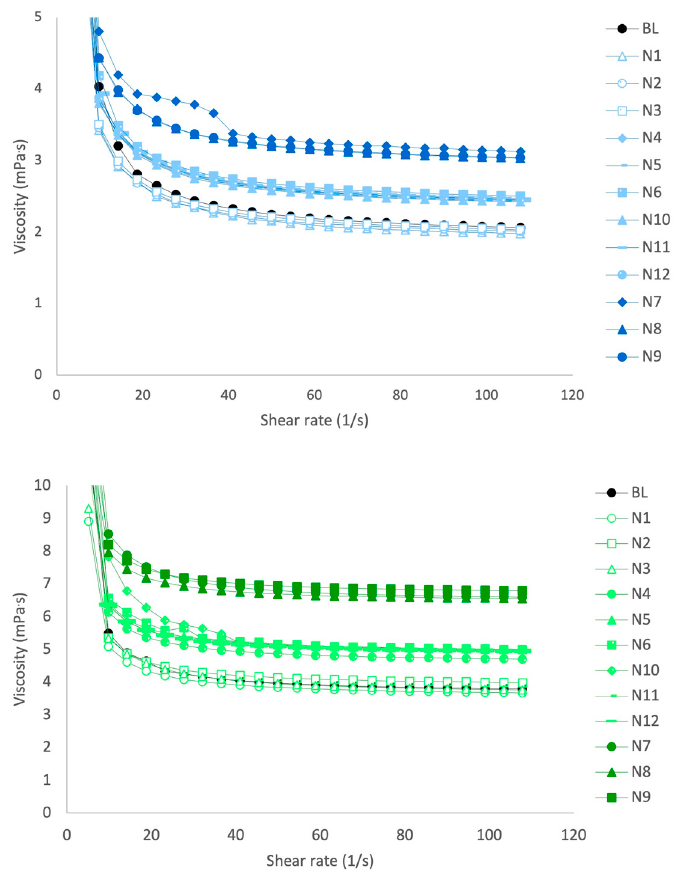
Figure 3. Viscosity as a function of shear rate for the oral liquids containing naloxone (( top figure ), blue) and propranolol (( bottom figure ), green) (mean value, n = 2). BL = baseline (original composition). Compositions of formulations N1–N12 according to Tables 4 and 5.